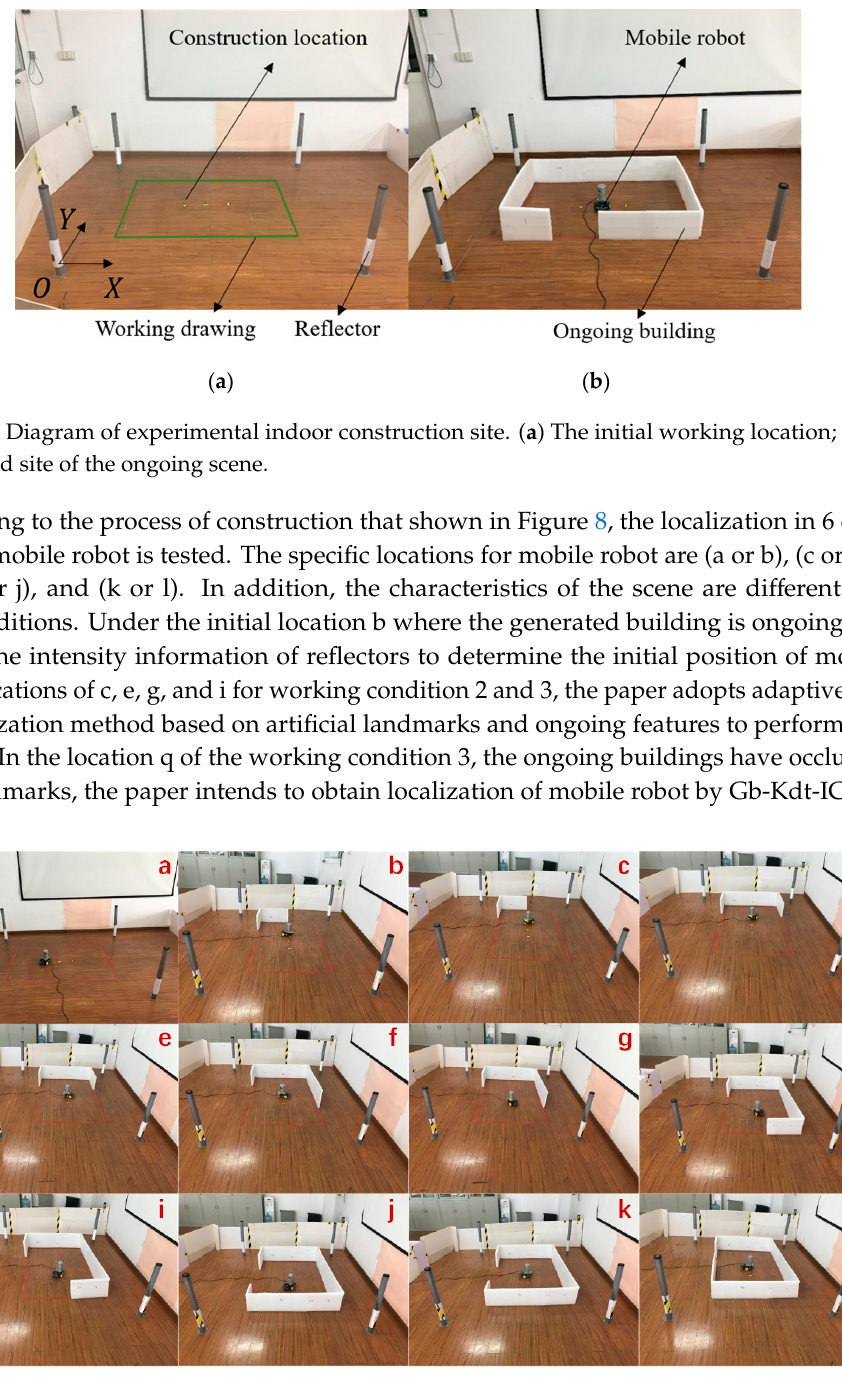
Figure 8. Flowchart of localization for mobile robot in ongoing scenes. ( a ) The initial scene of location a; ( b ) The ongoing scene of location b; ( c ) The ongoing scene of location c; ( d ) The ongoing scene of location d; ( e ) The ongoing scene of location e; ( f ) The ongoing scene of location f; ( g ) The ongoing scene of location g; ( h ) The ongoing scene of location h; ( i ) The ongoing scene of location i; ( j ) The ongoing scene of location j; ( k ) The ongoing scene of location k; ( l ) The ongoing scene of last location l.